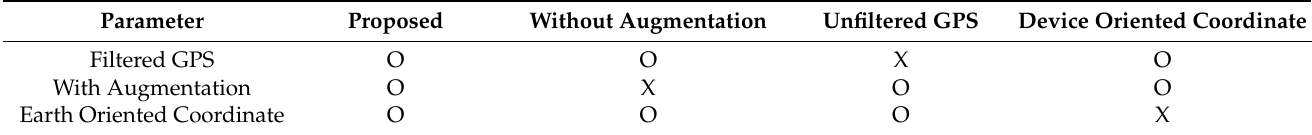
Table 4. Parameters for each training